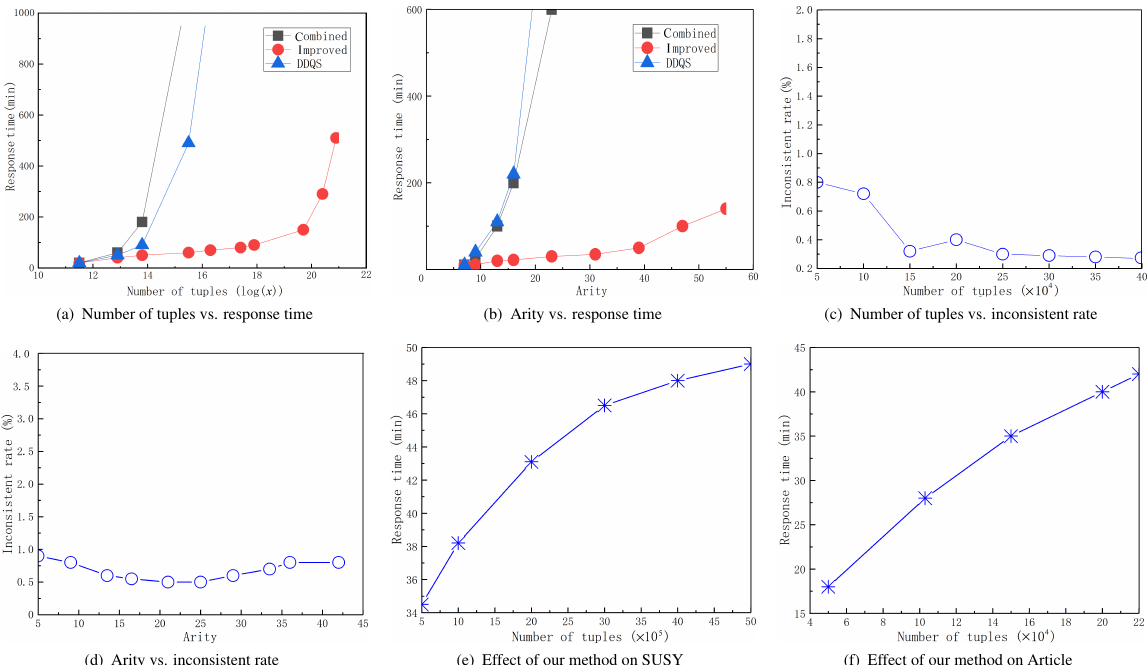
Fig. 5 Experiment